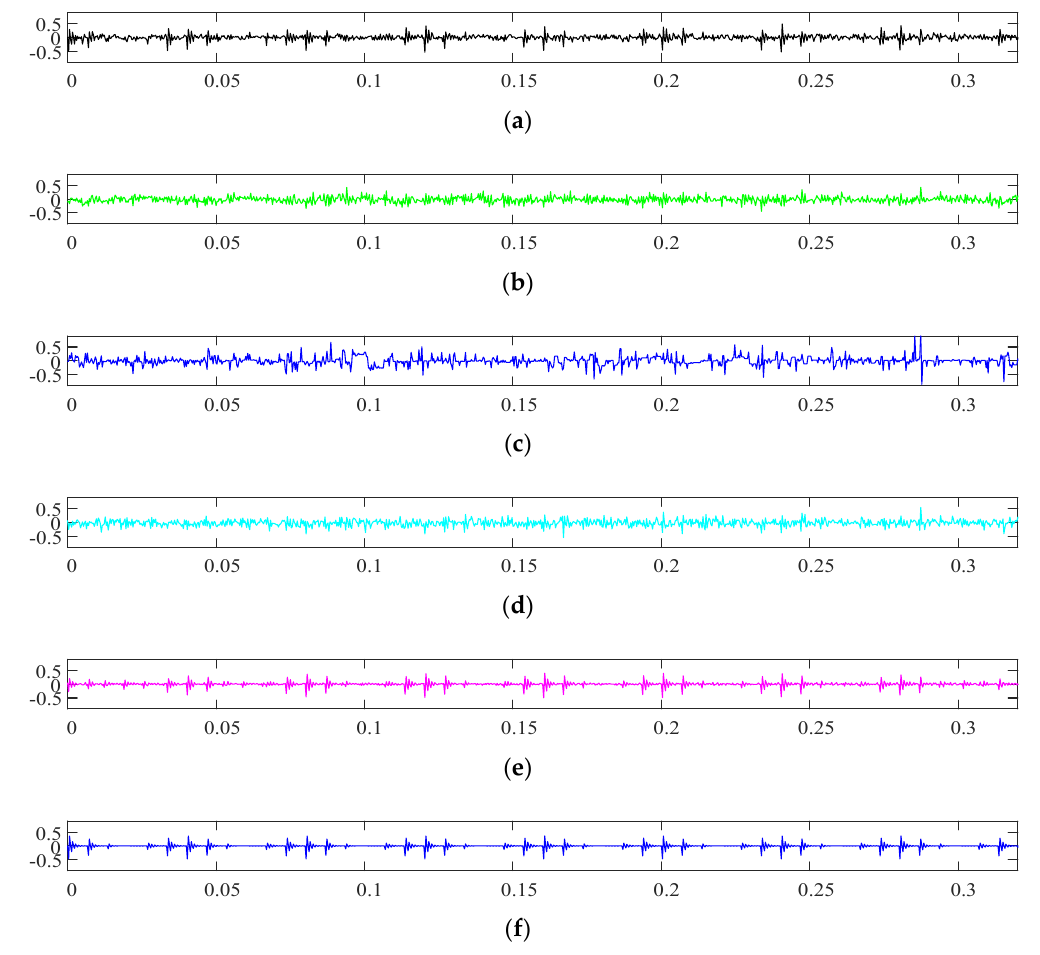
Figure 8. Simulation and reconstructed signals of each dictionary. ( a ) Simulation signal; ( b ) FFT; ( c ) Haar; ( d ) DCT; ( e ) DMD; and ( f ) noise-free signal. Table 3. Comparison of reconstructed signals with noise-free and noisy signals.